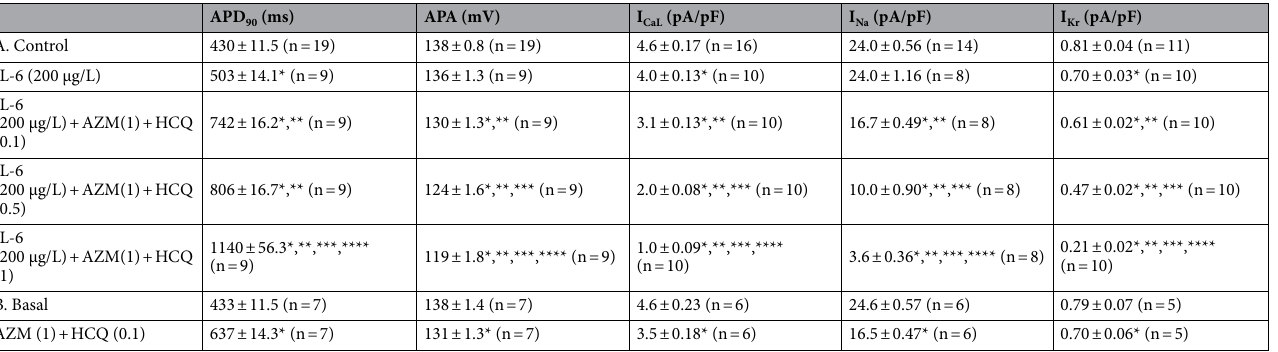
Table 3. Impact of the combination of IL-6, AZM and HCQ on action potential, I CaL , I Na and I Kr of guinea pig left ventricular myocytes. All values are expressed as mean ± SE. The number of experiments performed is indicated by “n = ”. Control conditions (A) refer to a separate group of cardiomyocytes versus basal conditions (B) which refer to the same group of cardiomyocytes used as their own control. In addition, one-way repeated measures analysis of variance was used to compare data between the treatments with IL-6 alone and the combination of AZM and HCQ for AP, APA, I CaL , I Na and I Kr in the same group of cardiomyocytes. * p < 0.05, versus Control; ** p < 0.05, versus IL-6 (200 μg/L); *** p < 0.05, versus IL-6 (200 μg/L) + AZM(1) + HCQ (0.1); **** p < 0.05 versus IL-6 (200 μg/L) + AZM(1) + HCQ (0.5). In (B), the paired t-test was used to compare data from AZM (1) and HCQ (0.1) for AP, APA, I CaL , I Na and I Kr with basal conditions (* p < 0.05 vs. Basal). The numbers in parenthesis next to the drugs indicate the corresponding multiple(s) of clinically relevant concentration (CRC). IL-6 Interleukin-6, AZM azithromycin, HCQ Hydroxychloroquine. AZM (1) = 41.5 mg/L; HCQ (0.1) = 5.0 mg/L; HCQ (0.5) = 24.9 mg/L; HCQ (1) = 49.8 mg/L.